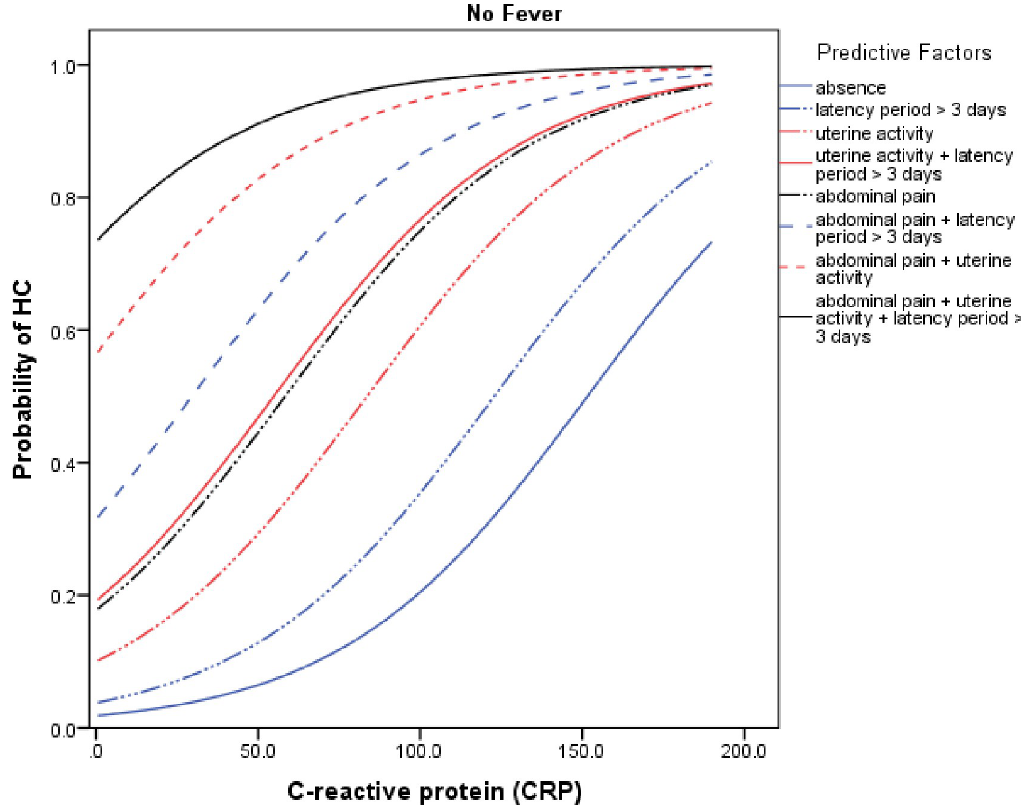
Fig 1. Probability curve of the HCA event according to CRP levels in the presence of various clinical conditions including maternal fever ( � 37.8 ˚C).